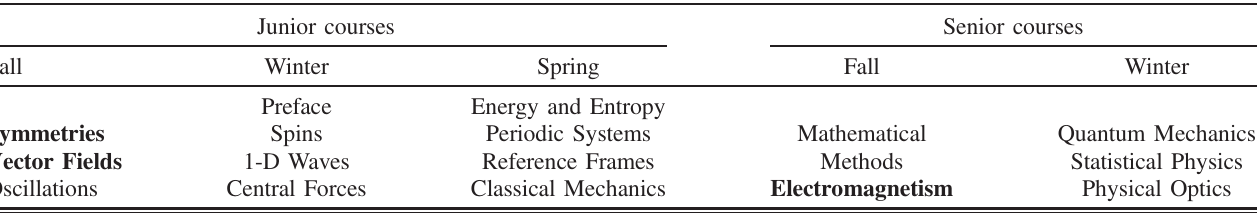
TABLE I. Standard schedule of Paradigms (junior year courses) and Capstones (senior year courses). Electricity and magnetism- related courses, during which the CUE is being administered, are highlighted in bold. Beginning in academic year 2011 – 2012 the Mathematical Methods and Classical Mechanics courses switched places, with the former now coming in the Spring and the latter in the